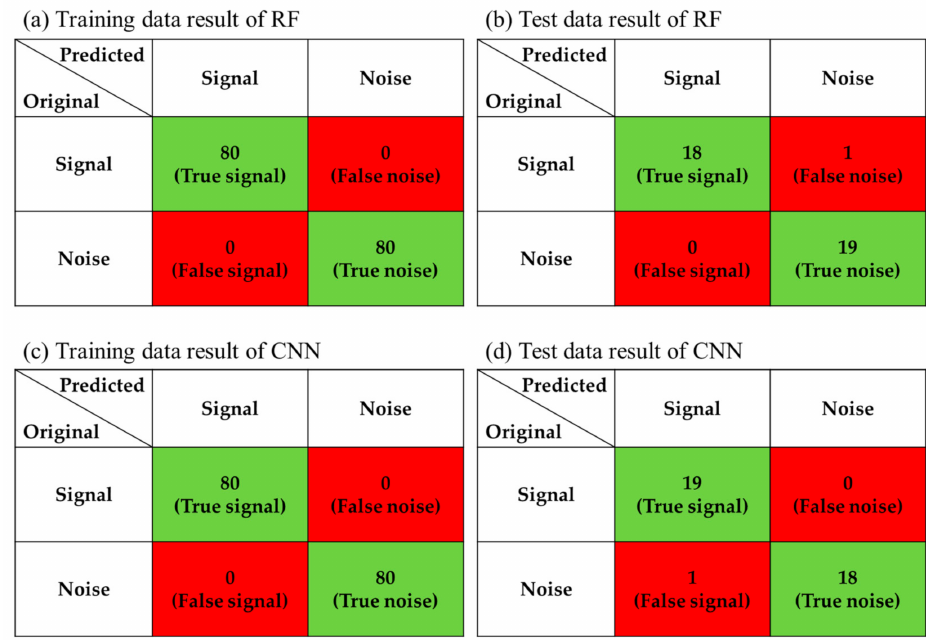
Figure 11. Learning results of training and test data sets by ( a , b ) random forest (RF) and ( c , d ) convolutional neural network (CNN). The top line means predicted classification from the machine learning model, and the far-left line is the original class. The green highlighted area indicates that the original class is matched to the predicted one and the red highlighted area means that the prediction fails to match the original